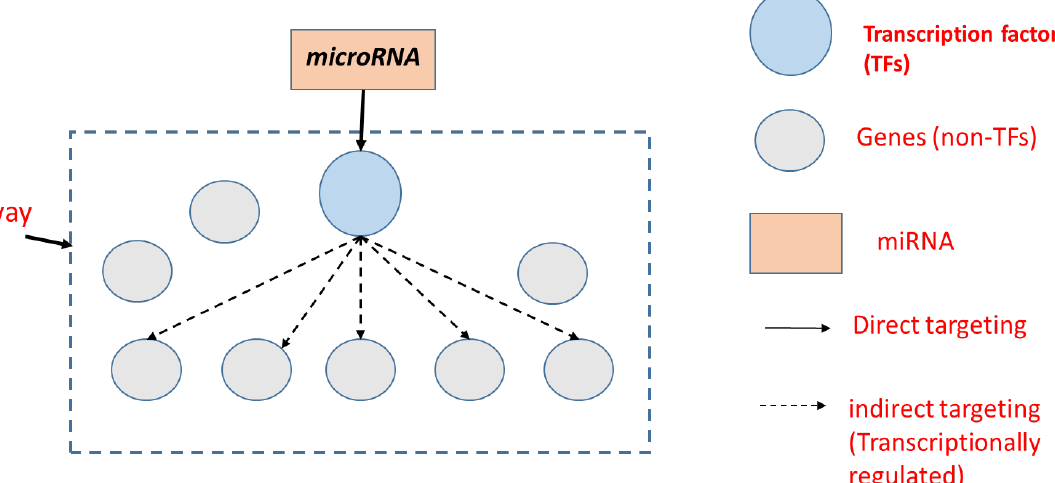
Figure 1. miRNAs can indirectly target biological pathways through transcriptions factors.